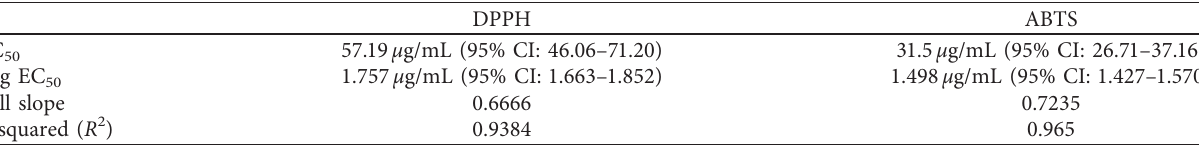
50 with logarithmic and nonlogarithmic concentrations for